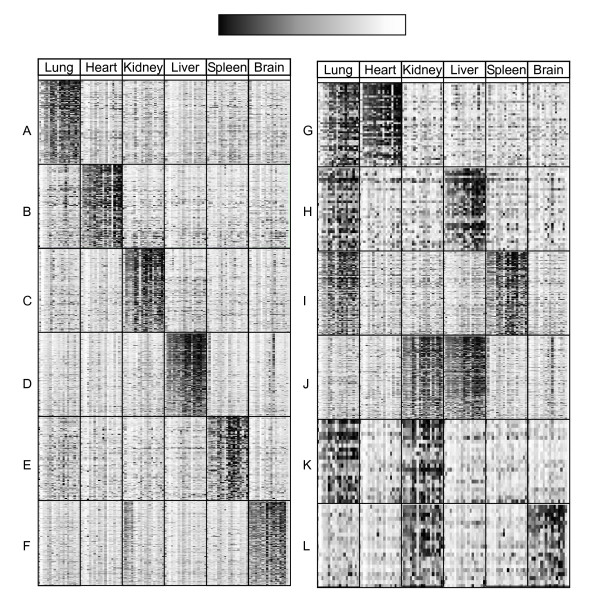
Hot maps of Organ-prominent genes. Left and right panels are the relative expression levels of genes differentially expressed in one and two organs, respectively. Each column represents 19 replicated hybridizations of each organ and each row shows the spot signals of the organ-prominent genes. The scale of normalized spot signals was indicated on the top of the graph. (A): lung: 166 genes; (B) heart: 100 genes; (C) kidney: 186 genes; (D) liver: 324 genes; (E) spleen: 88 genes; (F) brain: 225 genes; (G) lung-heart: 47 genes; (H) lung-liver: 33 genes; (I) lung-spleen: 95 genes; (J) kidney-liver: 174 genes; (K) lung-kidney: 21 genes; (E) kidney-brain: 21 genes.